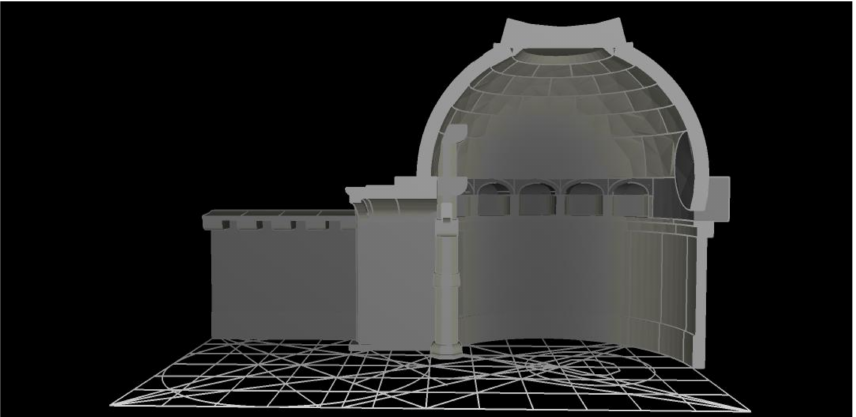
Figure 23. Section of the initial model.